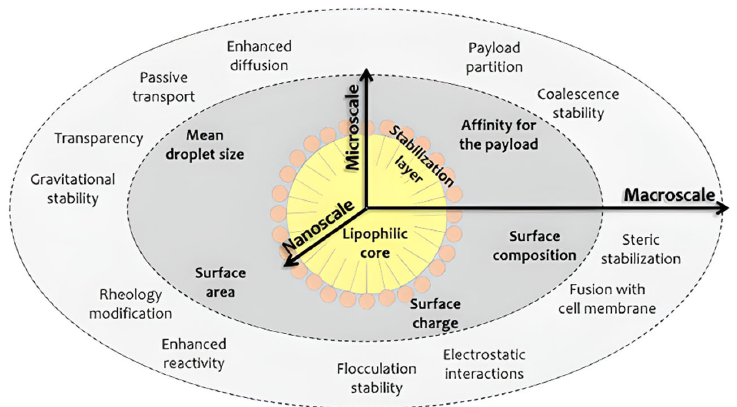
Figure 10. Schematic representation of nanoemulsion and related properties at different sizes (reproduced with copyright permission from Donsì [199]).